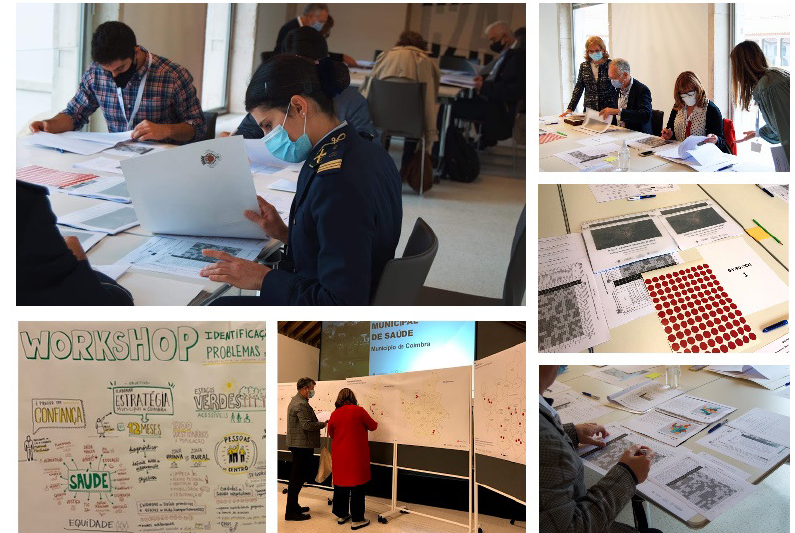
Figure 5. Photos illustrating the consultation process held in the stakeholder